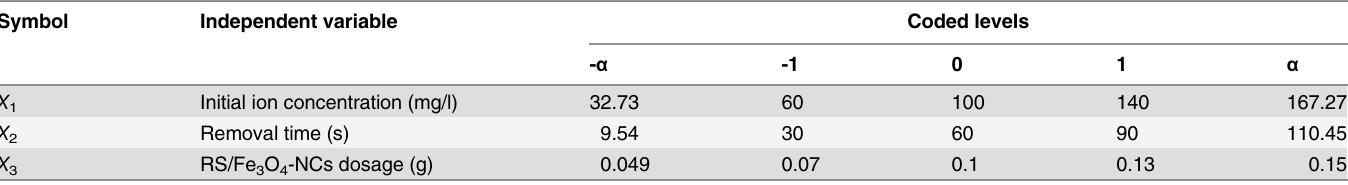
Table 1. Coded independent variables used in RSM design.